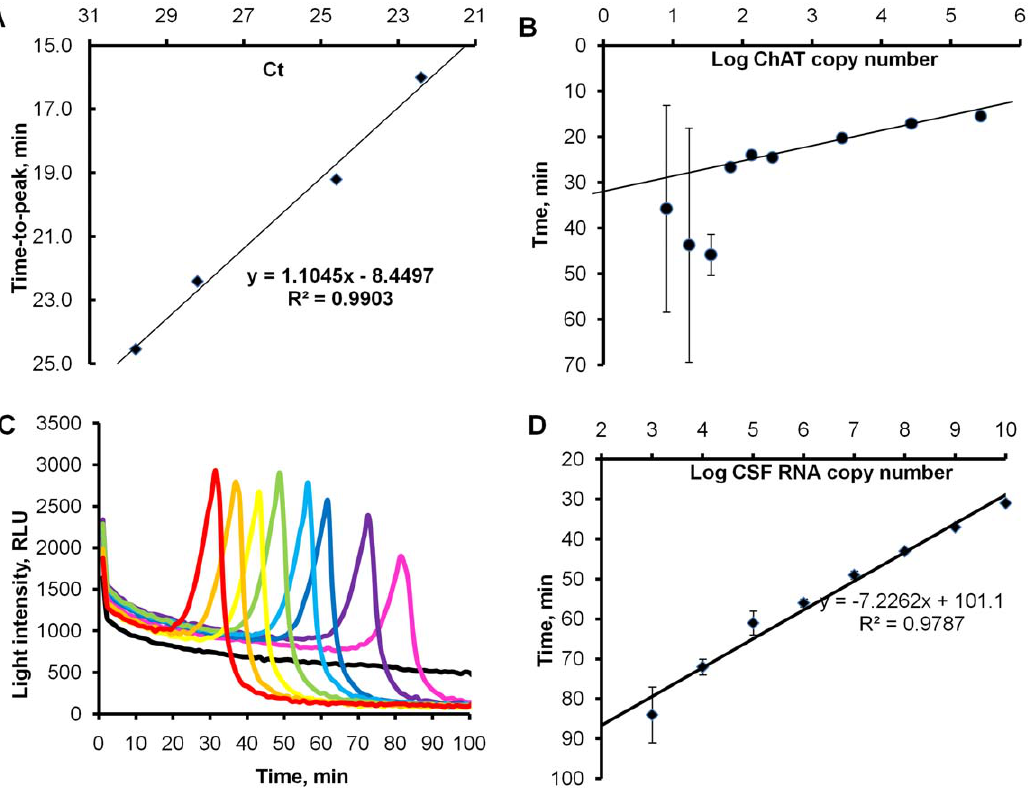
Figure 7. DNA and RNA analysis using LAMP-BART. (A) Correlation between t max values in LAMP-BART (vertical axis) and Ct values in TaqMan PCR (horizontal axis) obtained in the side-by-side analysis of the samples from the CT QCMD panel. (B) Effect of increased levels of foreign DNA (1.2 m g salmon sperm DNA/assay) on the sensitivity and speed of ChAT LAMP-BART assay carried out in 26- m l at 60 u C. (C) Real-time bioluminescent assay of CSFV RNA fragment dilution series amplified by RT-LAMP at 55 u C for 100 min (raw experimental data): 10 10 copies – red, 10 9 – orange, 10 8 – yellow, 10 7 – green, 10 6 – light-blue, 10 5 – dark-blue, 10 4 – violet, 10 3 – pink, NTC - black. Each curve represents one of three replicates. (D) Semi- logarithmic plot of the time-to-peak versus CSFV RNA copy number in the same RT-LAMP-BART reactions.